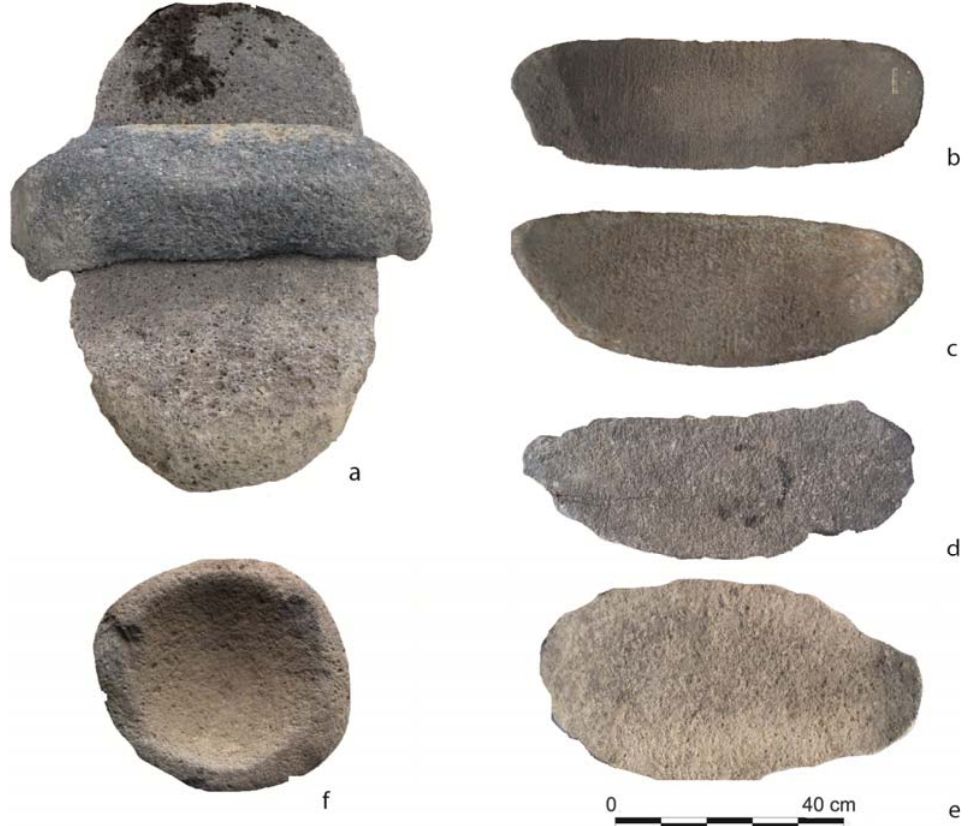
Figure 8. Early Bronze age macrolithic implements. a. example of complete grinding tools system with overlapping grinder from Mentesh tepe; Example of overlapping grinders from b-c. Kwartrelebi; d-e. Davati; f. small mortar from Davati (photographs by C.